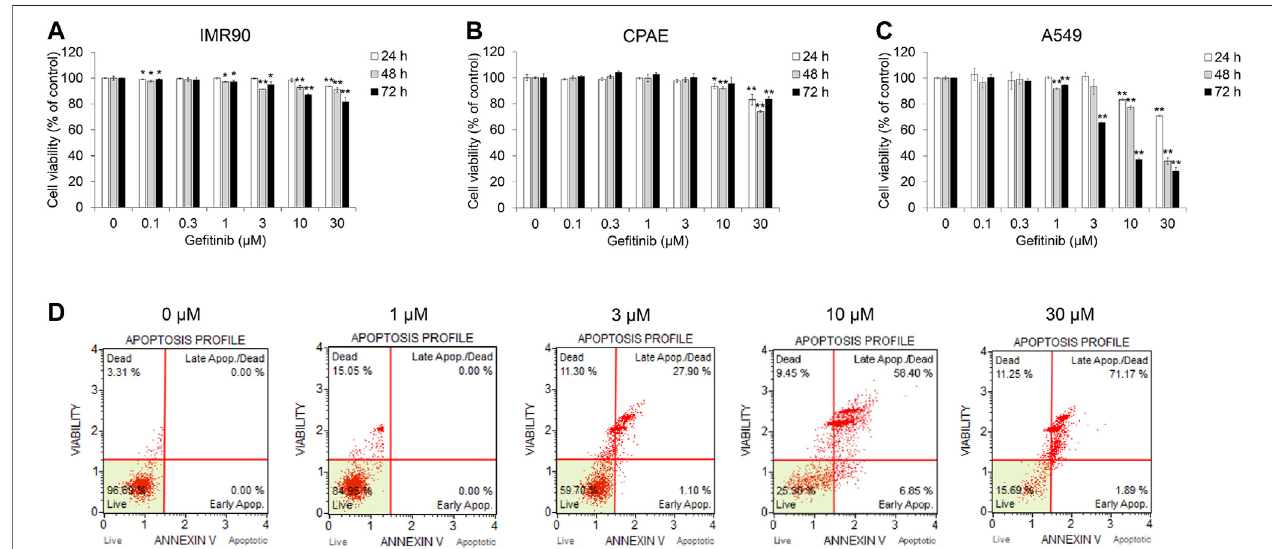
FIGURE 1 | Ge fi tinib inhibits proliferation of human NSCLC A549 cells. (A) A549, (B) CPAE and (C) IMR90 cells were treated with ge fi tinib for 24 – 72 h. After incubation, cell viability was measured by the CCK-8 assay. (D) A549 cells were incubated with ge fi tinib for 72 h, and then the populations of apoptotic and dead cells were analyzed using the MUSE Cell Analyzer. Experiments were performed in triplicate. Data represent mean ± SD. * p < 0.05, ** p < 0.01 versus untreated control.